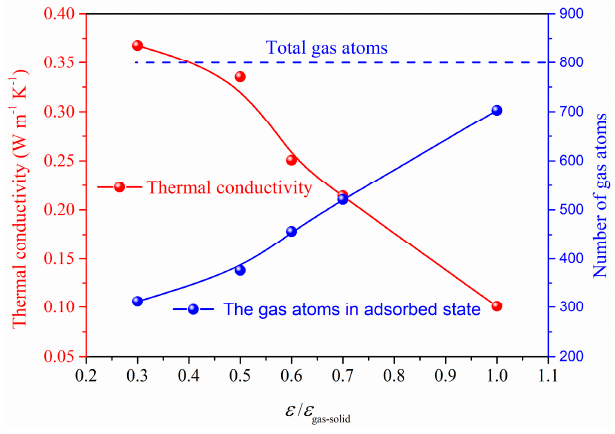
Figure 11. Absorbed atoms and thermal conductivity for constant gas atoms.